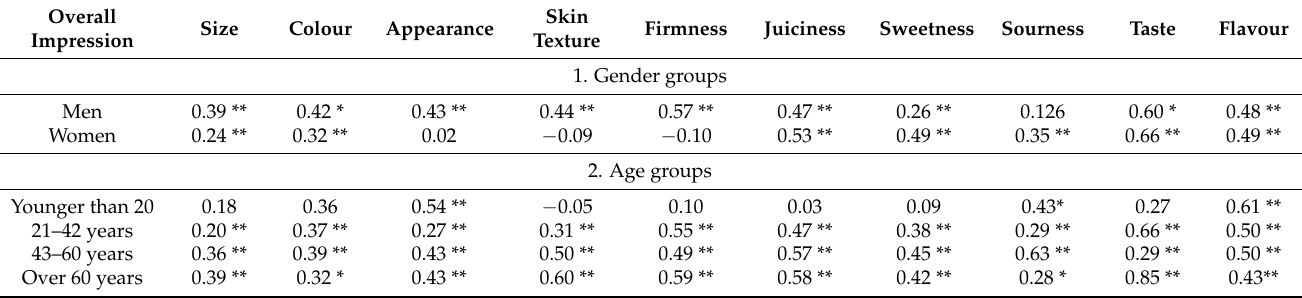
Table 6. Pearson correlation coefficients between overall impression and other sensory attributes (appearance, size, colour, firmness, skin texture, juiciness, sweetness, sourness and flavour) by different gender and demographic groups. Overall Impression